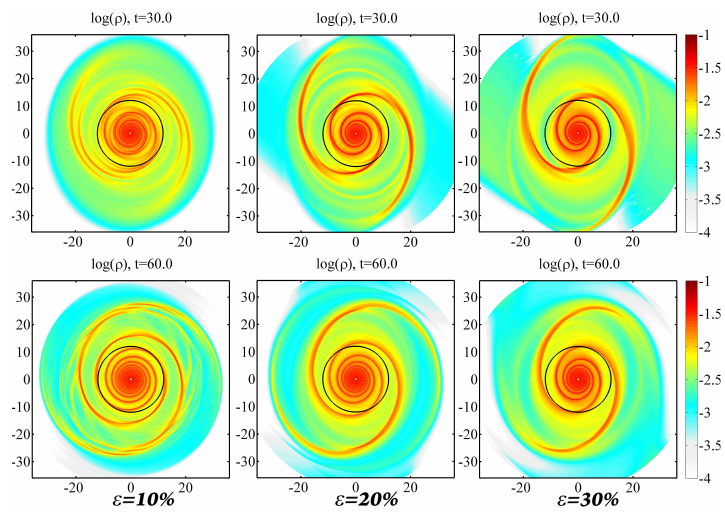
Fig. 3. Gas density distribution lg( σ ( r,ϕ )) in the model with Q T = 2 . 8 at time instants t = T 0 (top row) and t = 2 T 0 (bottom row), where T 0 is the disk rotation period at the outer edge. The columns represent three values of the DM halo potential non-axisymmetry parameter ε . The black circle shows the optical size.